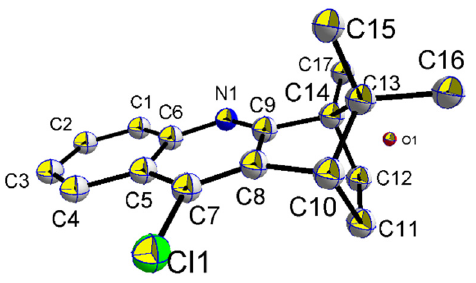
Figure 7. Crystal structure of complex 5a with 50% thermal ellipsoids. Hydrogen atoms are omitted for clarity.